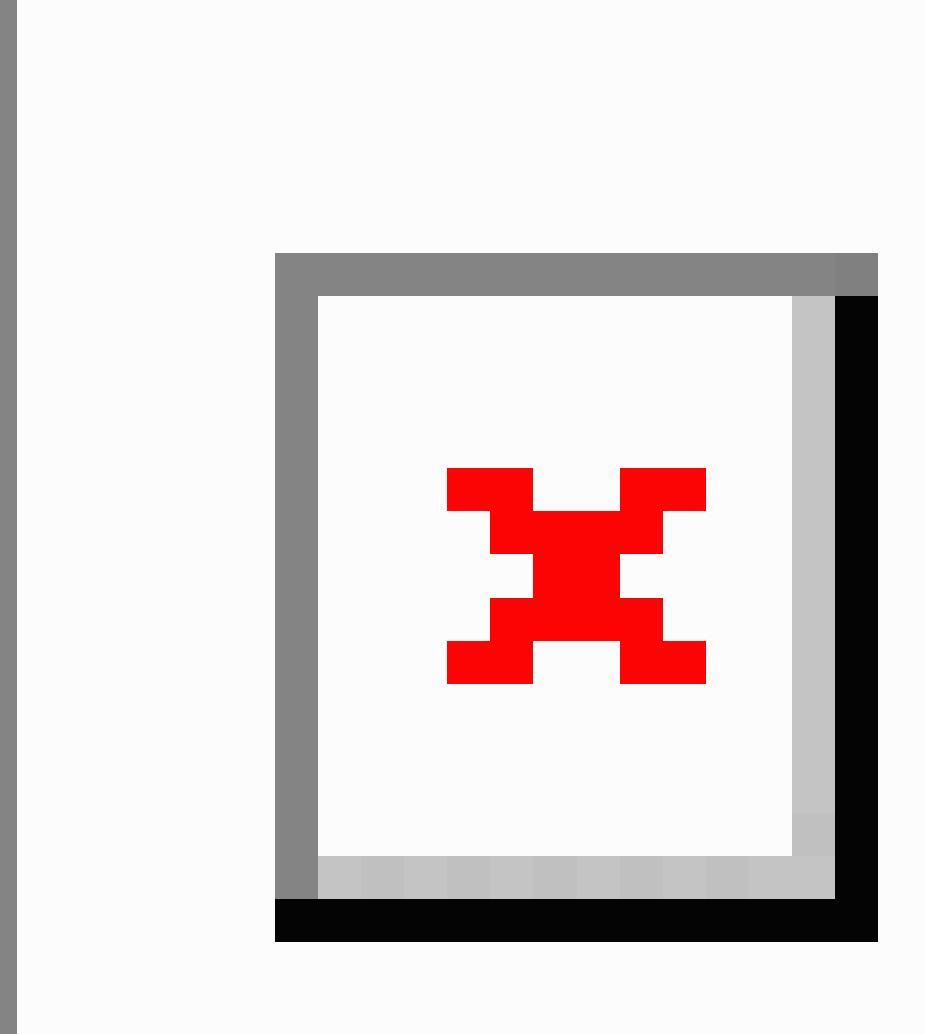
Figure 4. Symptoms and activity